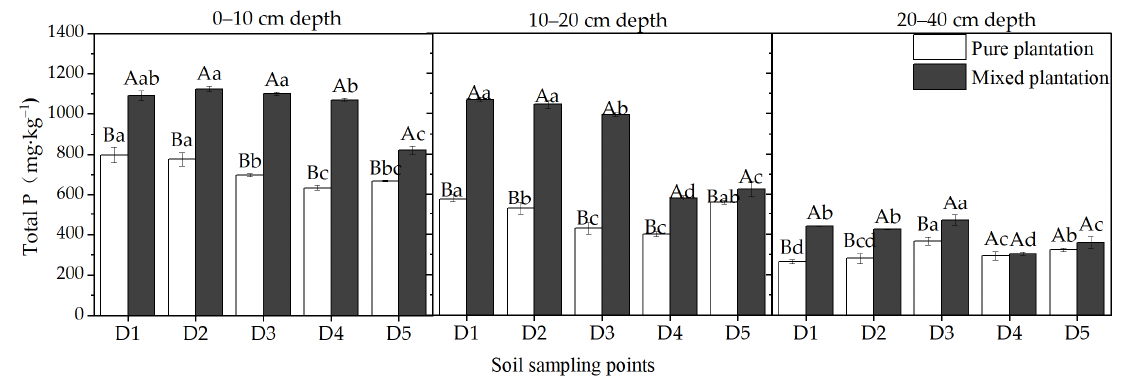
Figure 4. Concentrations of total P at different soil sampling points in the pure larch plantation and mixed larch–ash plantation. Lowercase letters indicate significant differences among different soil sampling points in the same plantation, p < 0.05; capital letters indicate significant differences among different plantations at the same sampling point, p < 0.05. n = 3, standard deviation bars are shown.